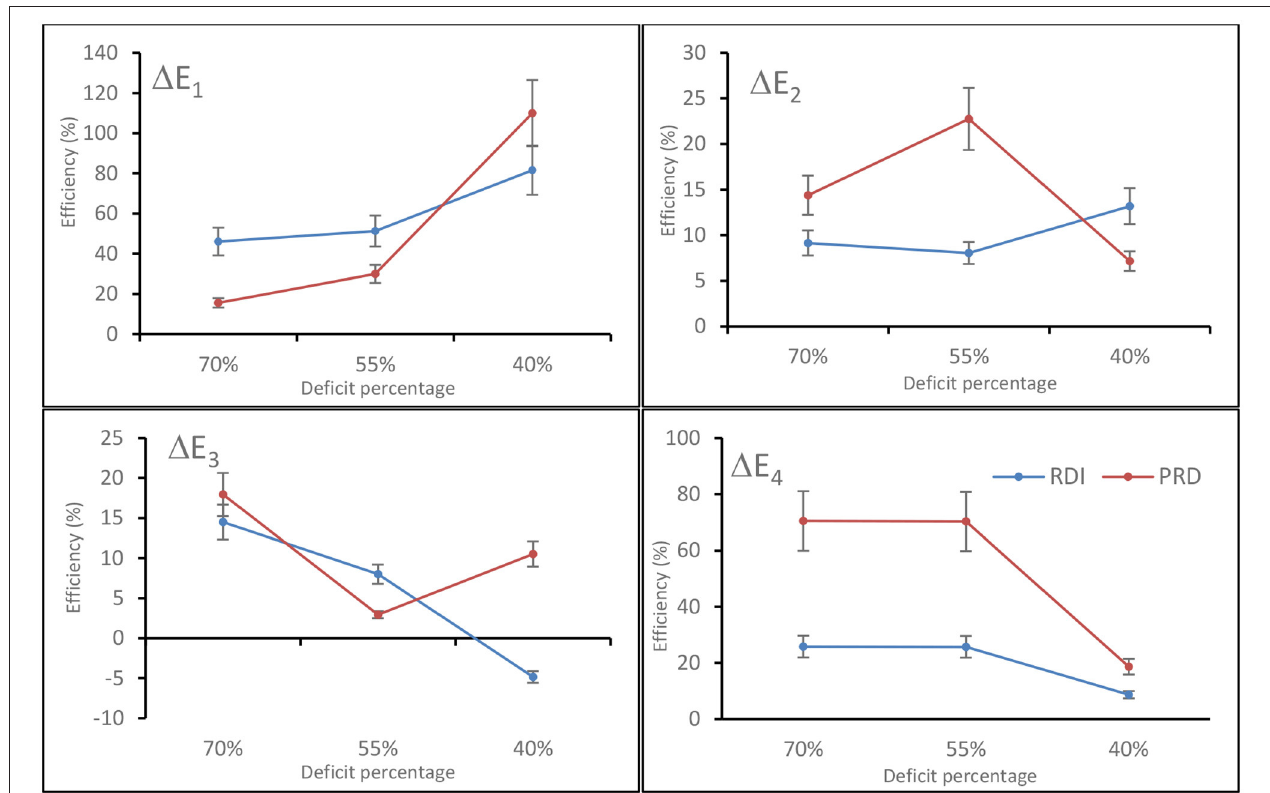
FIGURE 4 | The percentage of an improvement in the efficiency of each step in the 2nd cutting season compared to FI. * 1 : Parameter from Equation (8).